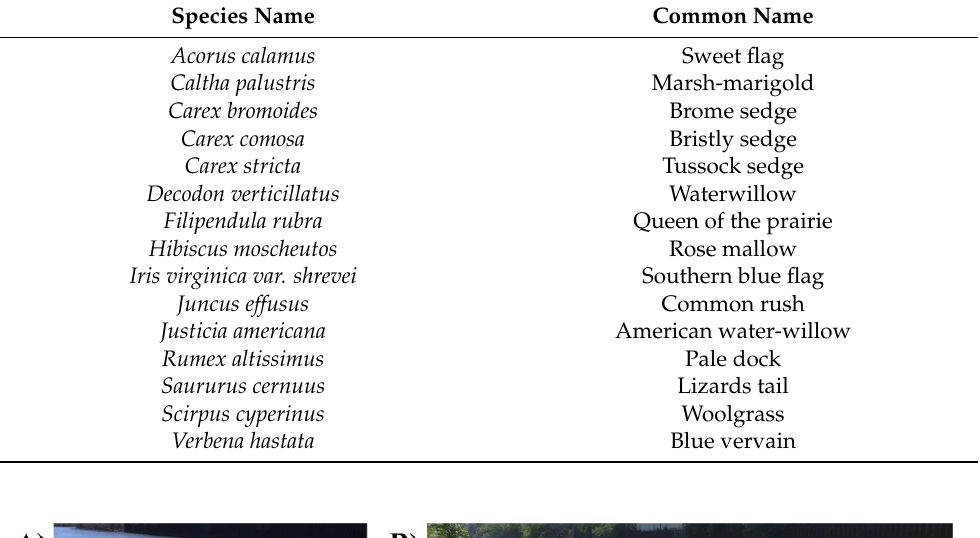
Table 1. Plant species that have experienced successful growth in the AFWs.